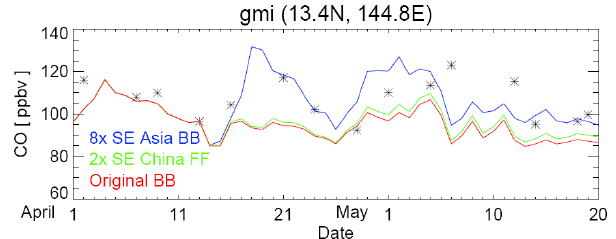
Fig. 3. Time series of simulated (lines) and observed (asterisks) CO mixing ratios at the Mariana Island site in Guam from 1 April to 20 May 2003. The model result using the GFED CO inventory is shown in red line. The sensitivity result with 8 times biomass burning CO emissions from the Indochina Peninsula (only in April) is shown in blue